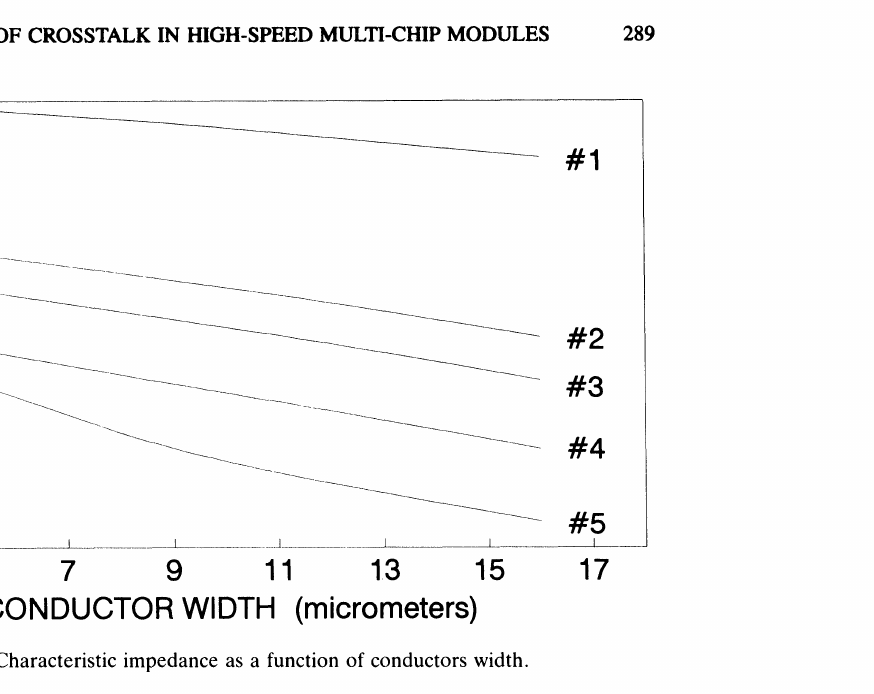
FIGURE 3 Characteristic impedance as a function of conductors width.